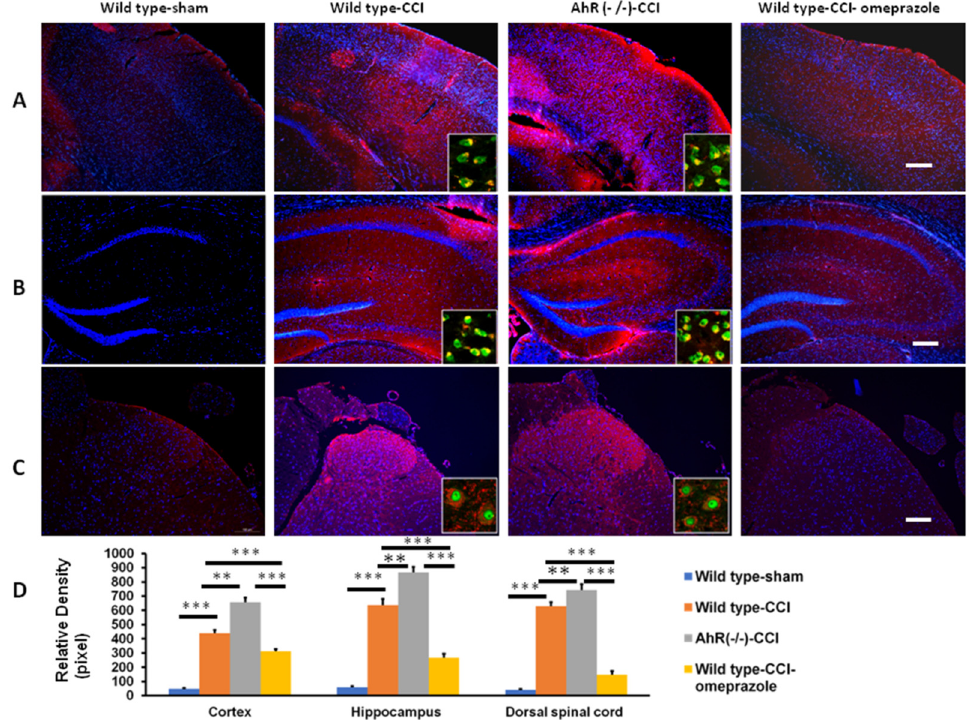
Figure 9. The expression of inflammatory cytokines in the central nervous system in CCI subjected to the modulation of AhR. Either wild or AhR-deleted mouse received CCI injuries and then were subjected to omeprazole treatment. The somatosensory cortex, hippocampus, and dorsal spinal cord were obtained for analysis 28 days after injury ( A ) Expression of TNF- α in the somatosensory cortex in the different experimental groups. ( B ) Expression of TNF- α in the hippocampus in the different experimental groups. ( C ) Expression of TNF- α in the dorsal spinal cord in the different experimental groups. ( D ) Quantitative analysis of TNF- α in different groups. Magnification box indicates the imaging fusion of TNF- α and Neu-N (green). DAPI = blue; Bar length = 100 μ m; N = 6; **: p < 0.01; ***: p < 0.01. Wild type-sham; Wild type-CCI; AhR ( − / − )-CCI; Wild type-CCI-omeprazole: see text.